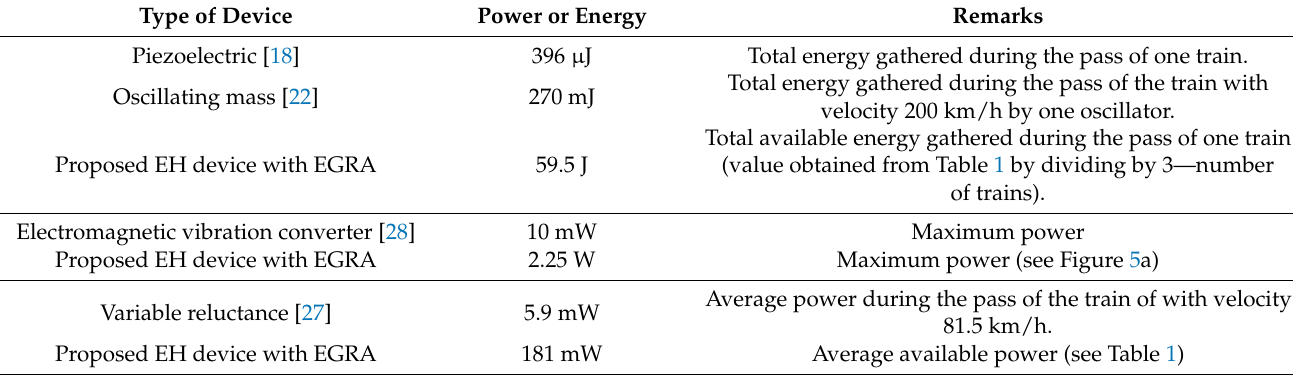
Table 2. The comparison of proposed EH method to known unconventional energy harvesting methods. Type of